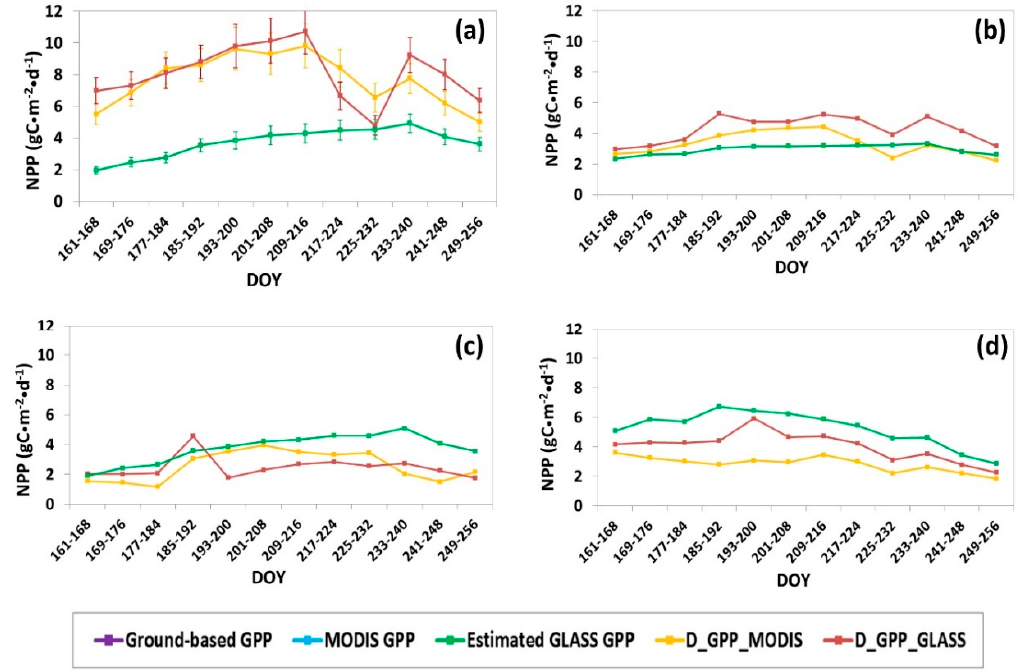
Figure 16. Comparison of estimated GLASS NPP, D_NPP_MODIS and D_NPP_GLASS: ( a ) Cropland; ( b ) orchard; ( c ) vegetable field; ( d ) wetland. Note that the NPP in cropland are the mean values of all sites in cropland.